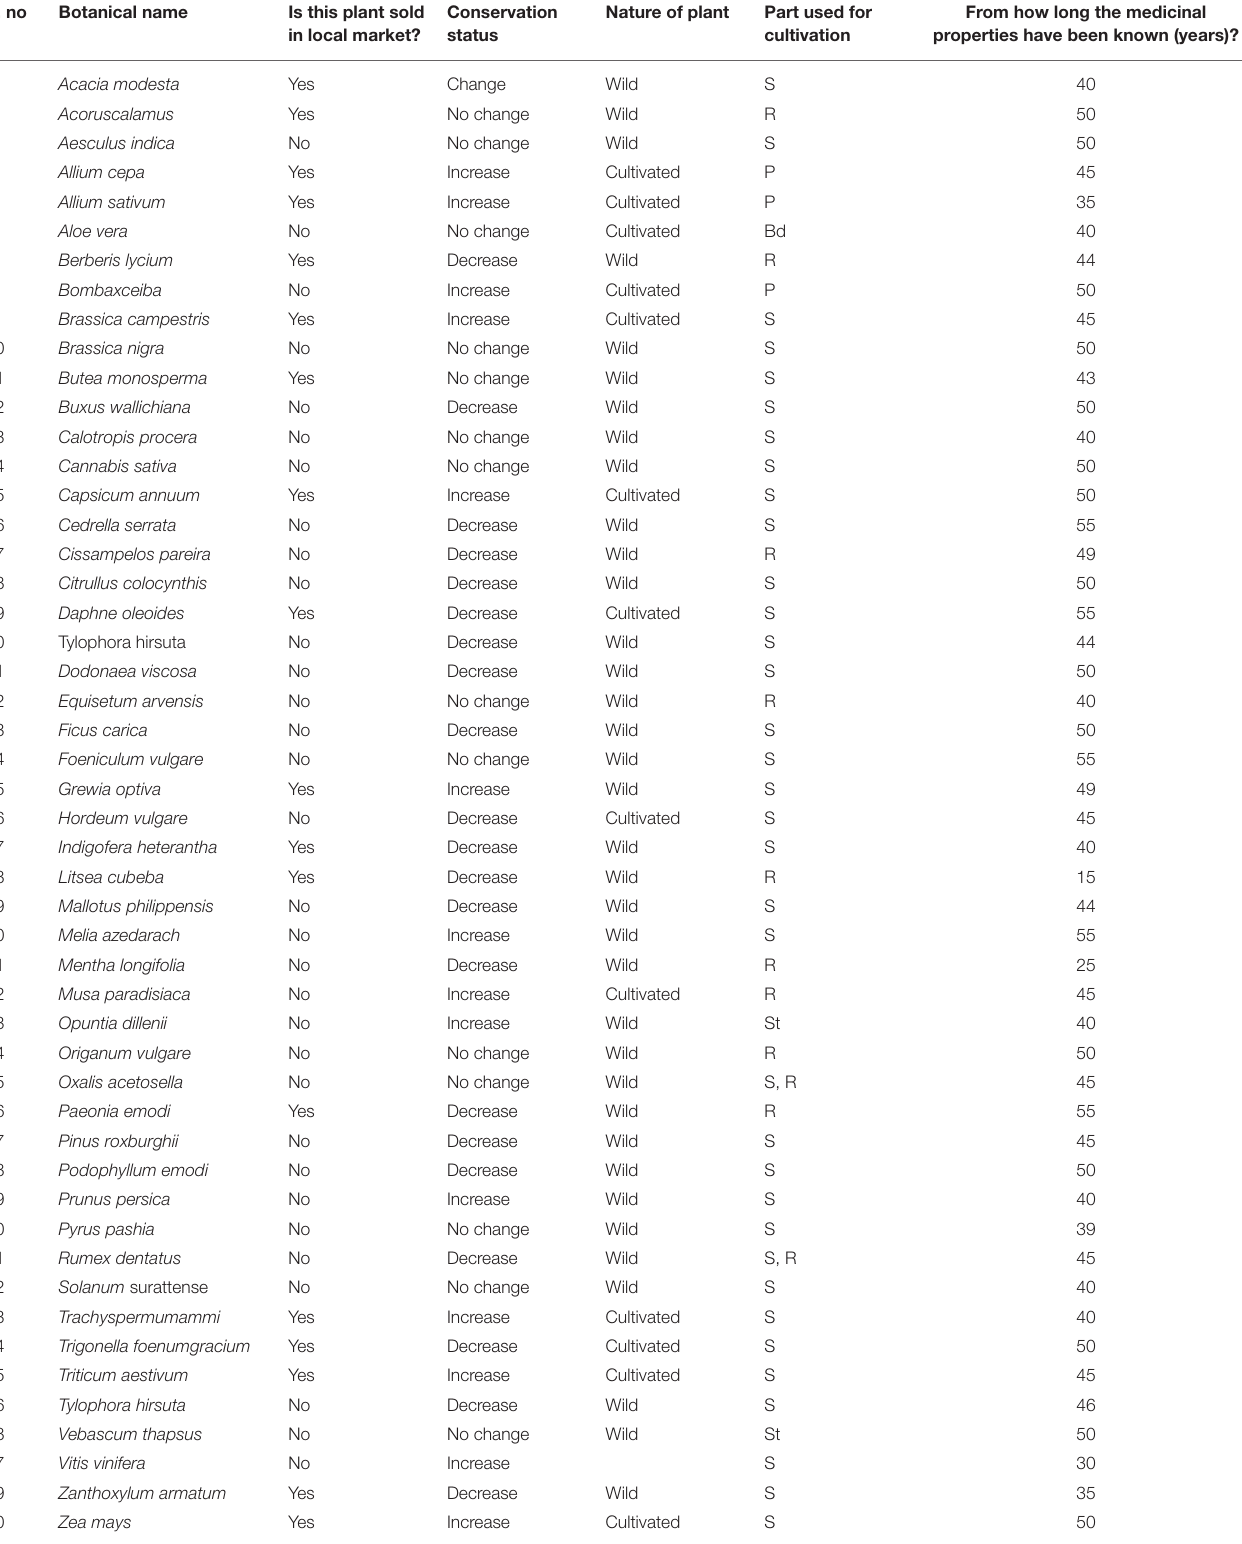
TABLE 2 | Market availability, status, nature, part for cultivation, and therapeutic practices of the medicinal plants recorded from Chamla Valley. S.